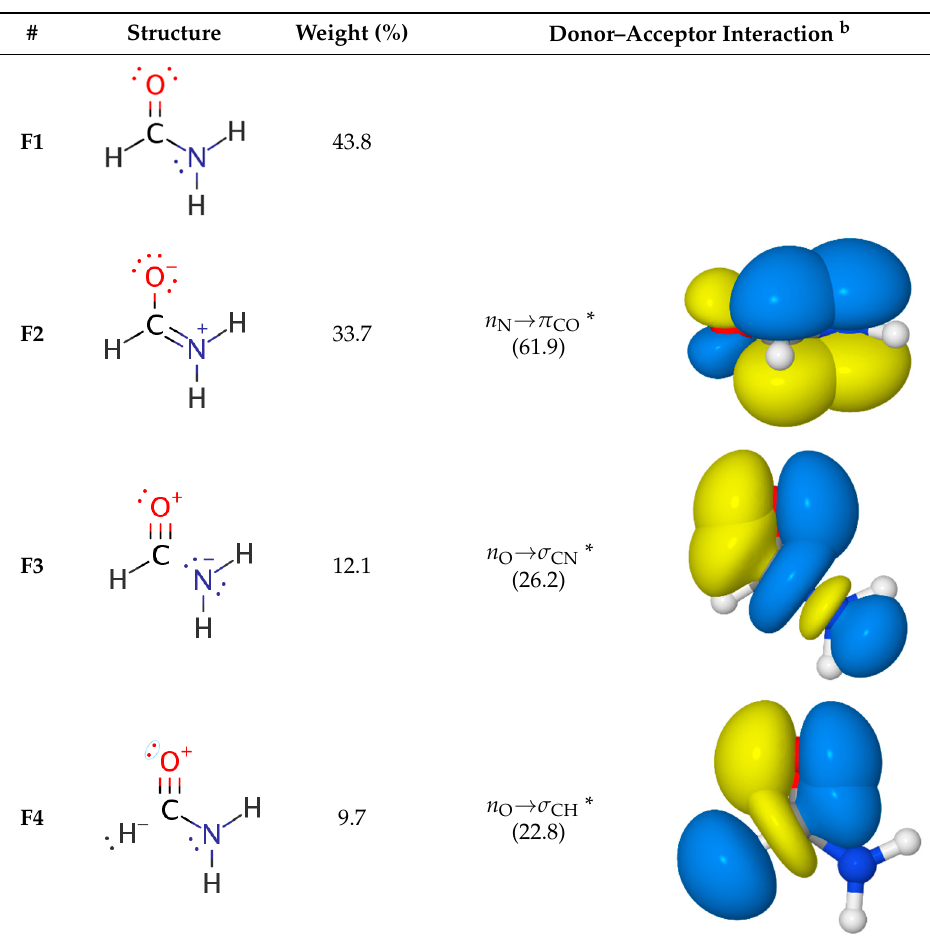
Figure 4. B3LYP/aVTZ energy profile for the tautomerization of formamide (F) to formimidic acid (FA). IRC = 0 corresponds to the transition state.